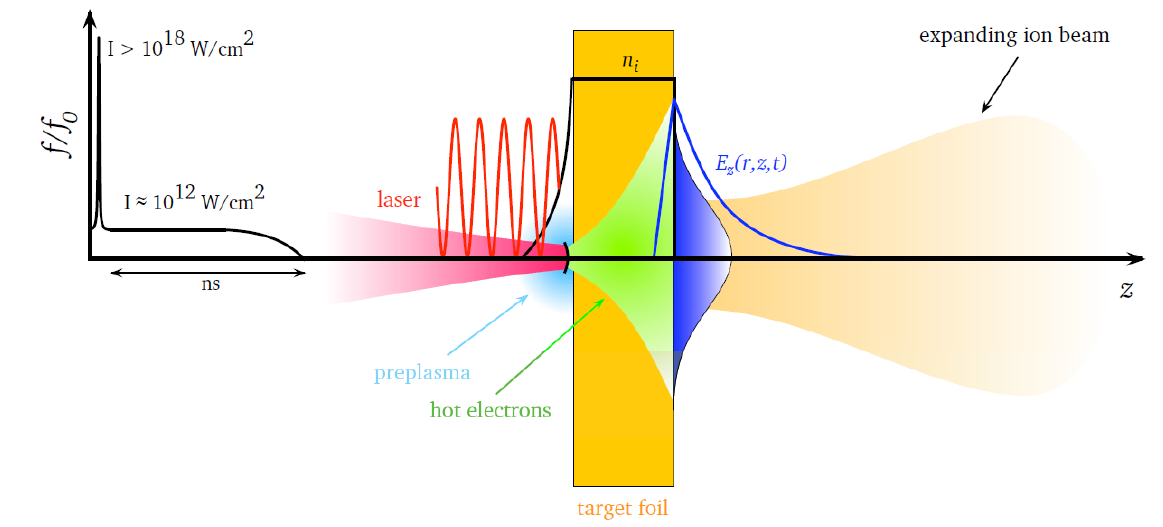
Figure 1. Target normal sheath acceleration graphic representation. Extracted from